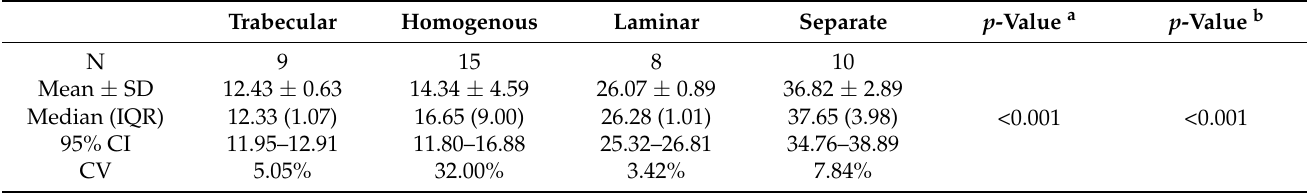
Table 1. The relationship between MHD and type of CSDHs based on internal structure (four- type classification).